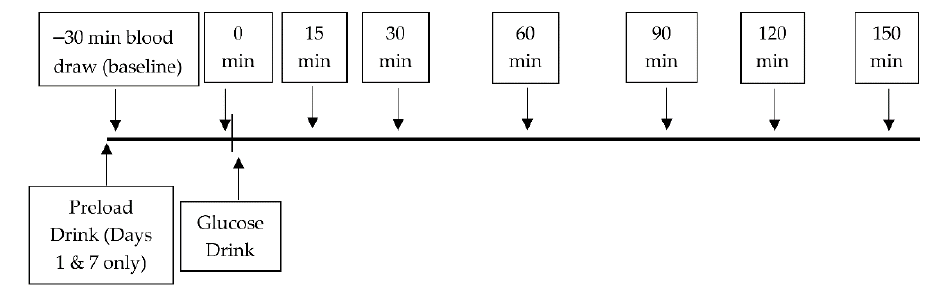
Figure 1. OGTT study design and blood sampling timepoints for day 0, 1 and 7.